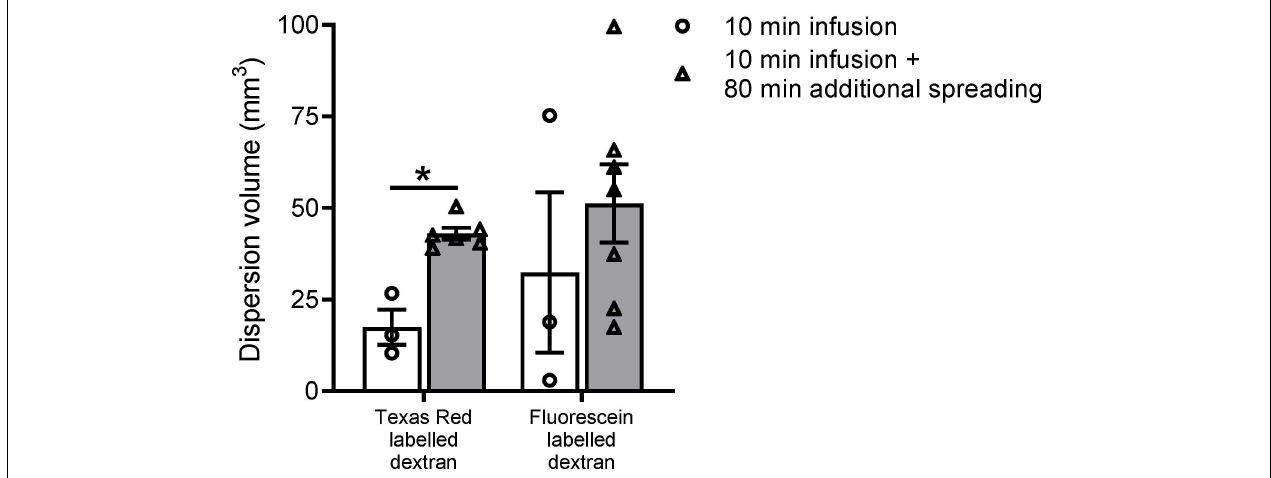
FIGURE 3 | Volume measurements of the tracer dispersion. The dispersion volume was significantly increased for the low molecular weight dextran labeled with Texas Red. For the high molecular weight fluorescein labeled dextran, the dispersion volume was much more variable and did not reach statistical significance. Data represent n = 3 for the subset of animals that were sacrificed directly after the infusion period of 10 min, and n = 6 or n = 7 for the group of mice that were sacrificed after an additional spreading period of 80 min after infusion. Values are mean ± SEM. ∗ p ≤ 0.05 (Mann–Whitney U